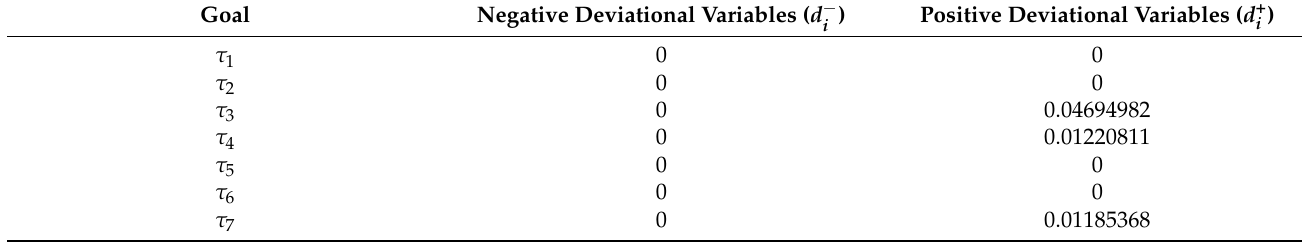
Table 6. Outcomes of deviational variables.